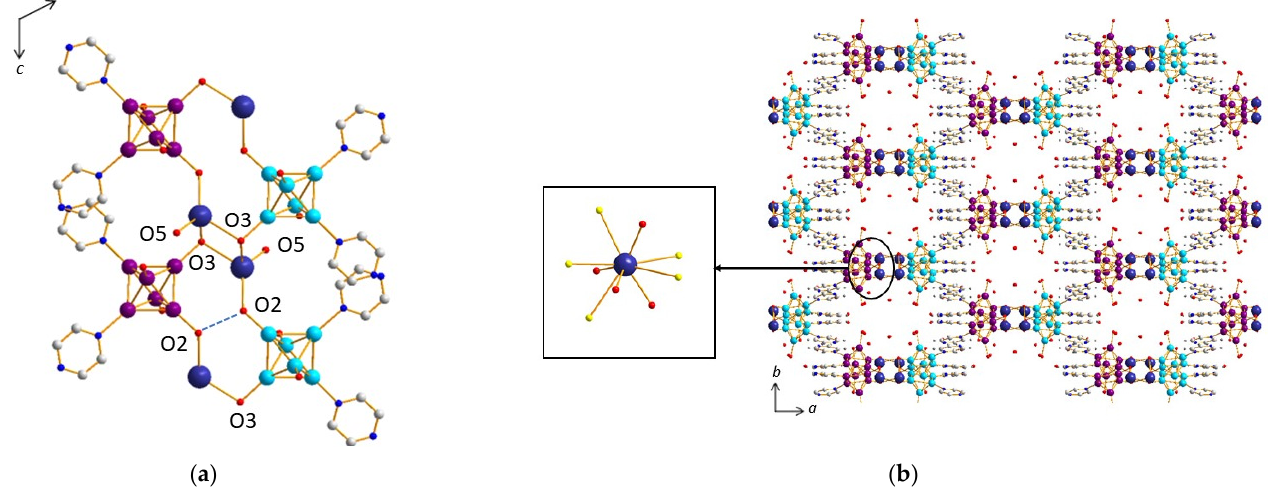
Figure 10. ( a ) Strong H bonds providing the layers’ connectivity in the structure of ( 5 ). ( b ) View of the structure of ( 5 ) along the c axis showing insertion of KO 4 S 5 polyhedra into the voids of the supramolecular framework.